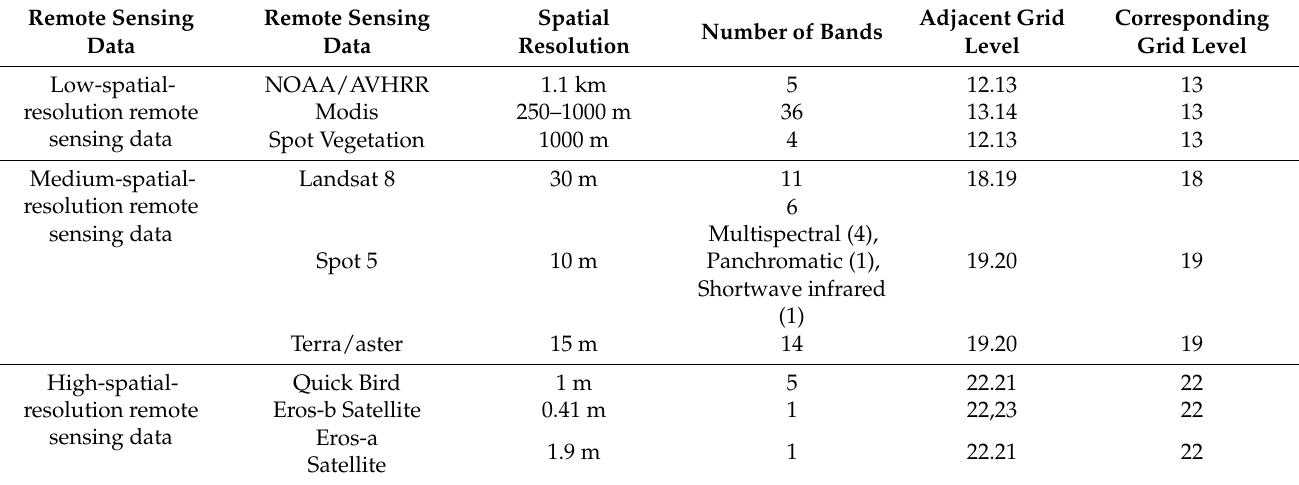
Table 1. Grid levels corresponding to commonly used high-, medium-, and low-resolution remote sensing images. Remote Sensing Remote Sensing Data Data